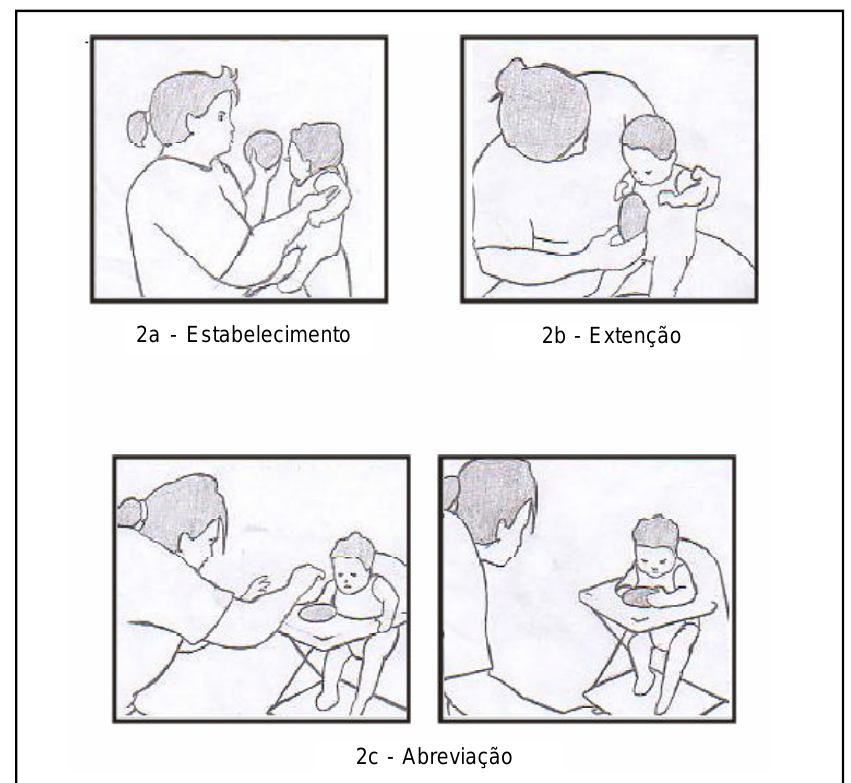
Figura 2 . Ilustrações